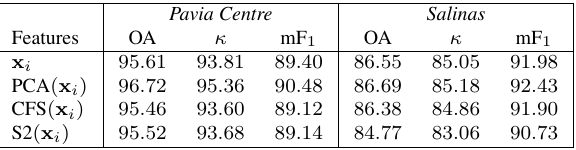
Table 2. Classification results (in %) achieved for the Pavia Cen- tre dataset and the Salinas dataset when using different data rep- resentations as input to a Random Forest